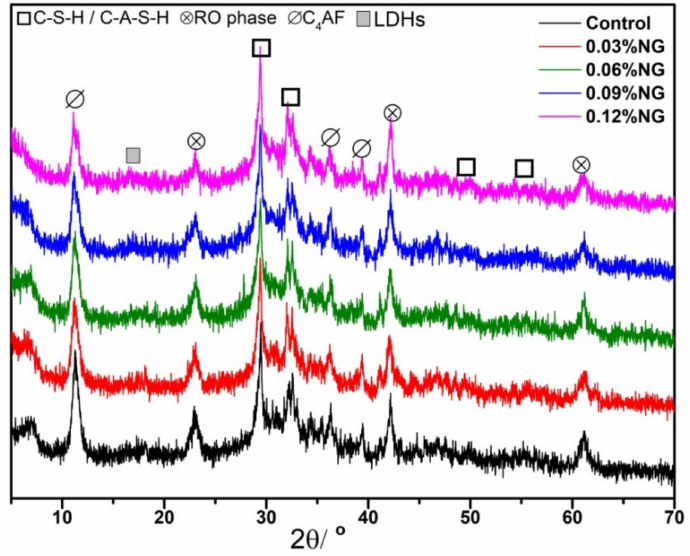
Figure 7. XRD patterns of specimens with GO.